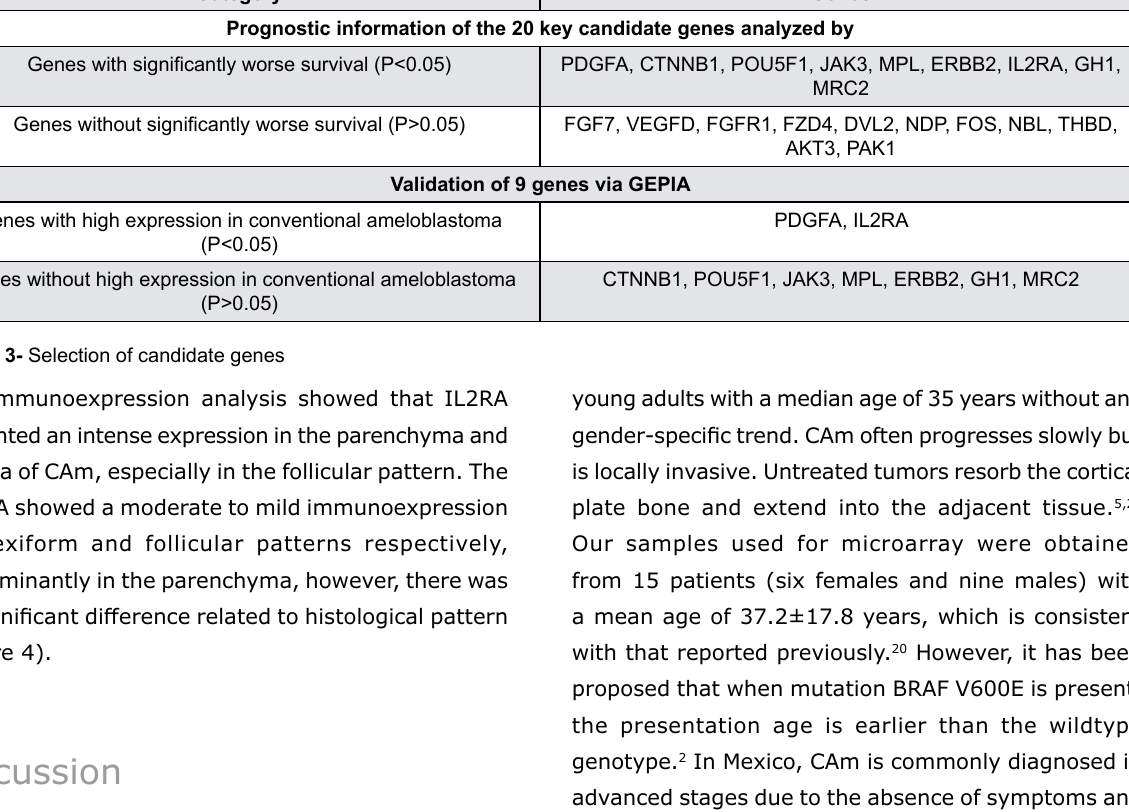
Figure 2- A) Prognostic information of the 20 core genes. Kaplan-Meier plotter online tool was used to analyze the prognostic information and nine genes were found to be significantly associated with survival rate (*p<0.05). B) Validation of the significant genes by GEPIA. The significant genes expressed in patients with ameloblastoma were compared to those in healthy individuals. Only platelet-derived growth factor A (PDGFA) and interleukin 2 receptor subunit alpha (IL2RA) showed significant differential expression (*p<0.05) Category Genes